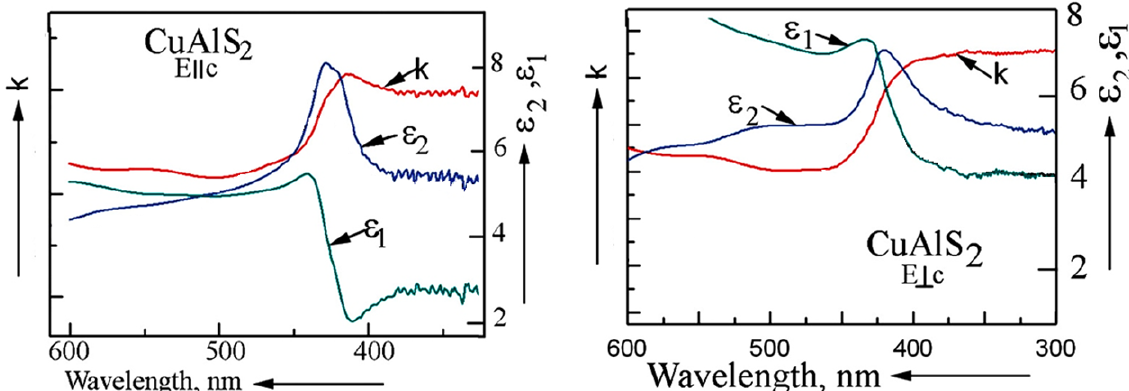
Figure 4. Spectral dependences of optical constants ε and E ⊥ c (right) for CuAlS